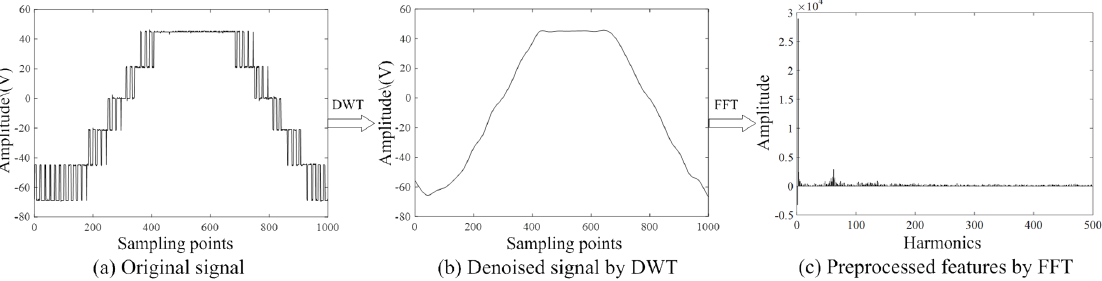
Figure 10. Processed results of original signal after denoising and preprocessing when H 1 S 1 has an Open Circuit (OC)